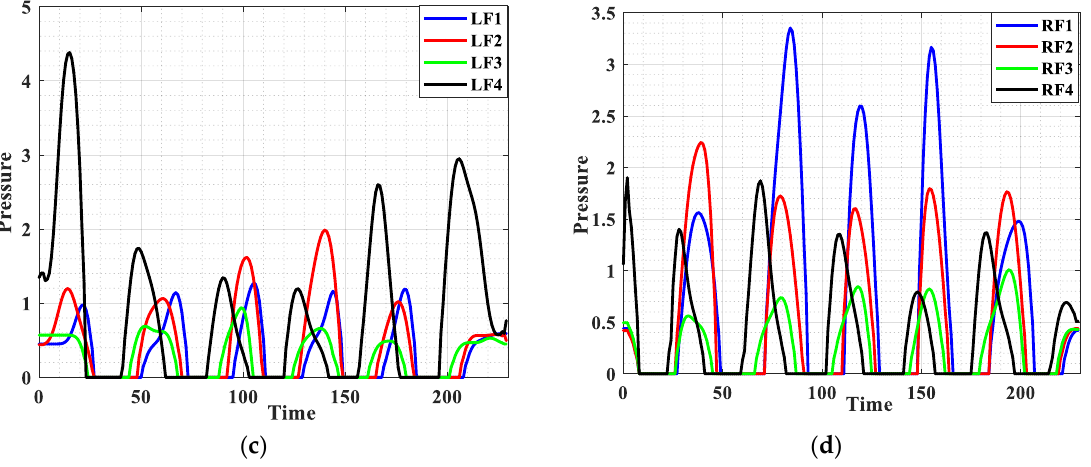
Figure 8. Division of plantar pressure and walking data. ( a ) Division of plantar pressure; ( b ) total pressure value of both feet; ( c ) left foot pressure value; ( d ) right foot pressure value.